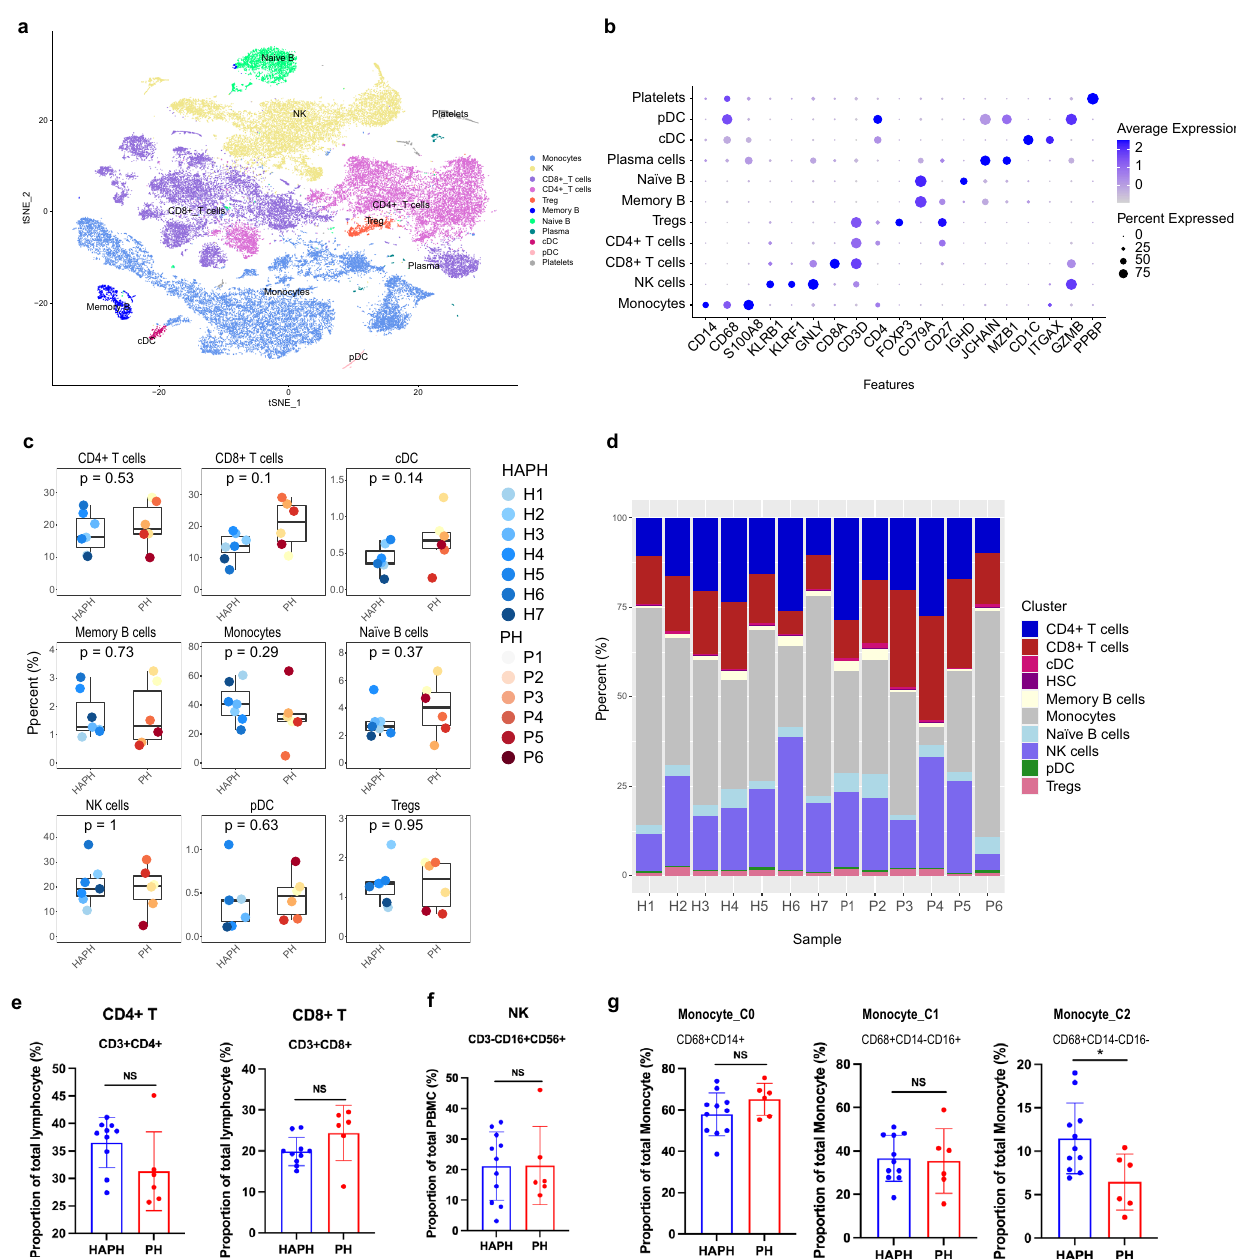
Fig. 7 | Immune cell composition in the circulation system of patients with PH and its comparison with those in HAPH. a t-SNE plot of the main immune cell subsets in PBMCs from patients with PH ( n =6). b Dot plot depicting the percen- tages and average expressions of the canonical genes associated with each main immune cell cluster in PBMCs from patients with PH ( n =6). c Boxplots comparing the percentages of each main cell type in PBMCs between HAPH ( n =7) and PH ( n =6) patients. The two-sided p values from the Wilcoxon rank-sum test were